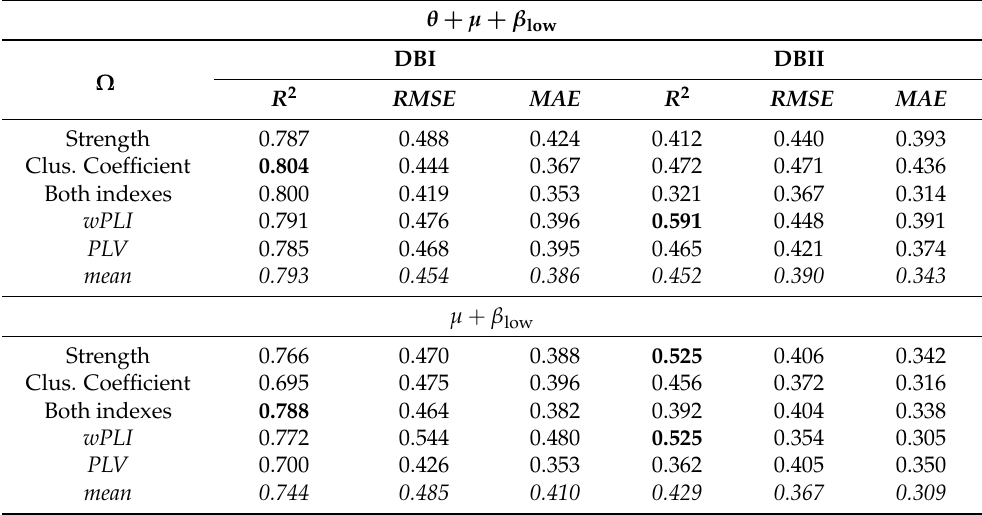
Table 3. Obtained prediction performance of the Wide&Deep neural network regression fed by the tested functional connectivity predictors extracted from the resting-state data, contrasting two different wide path configurations of rhythm extraction: considered rh and µ + β low